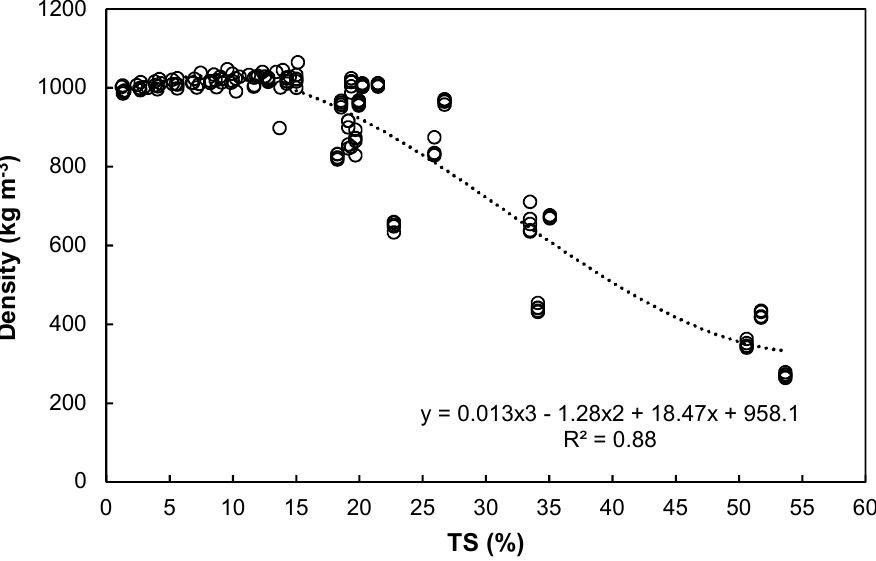
Figure 3. Density of pre-digested manure (farms A, C–G) as a function of TS content.